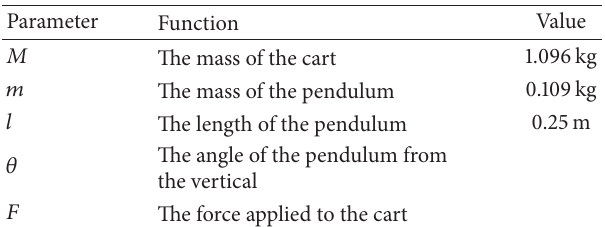
Figure 2: Membership function for the fan of nonlinear method. Table 1: Function